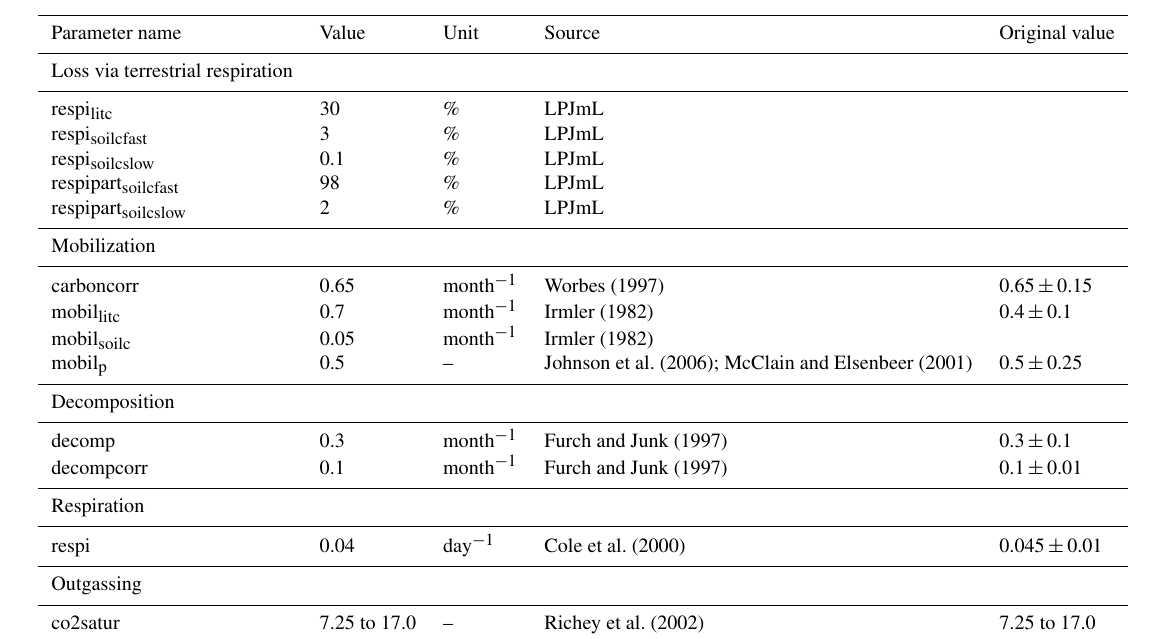
Table 3. List of